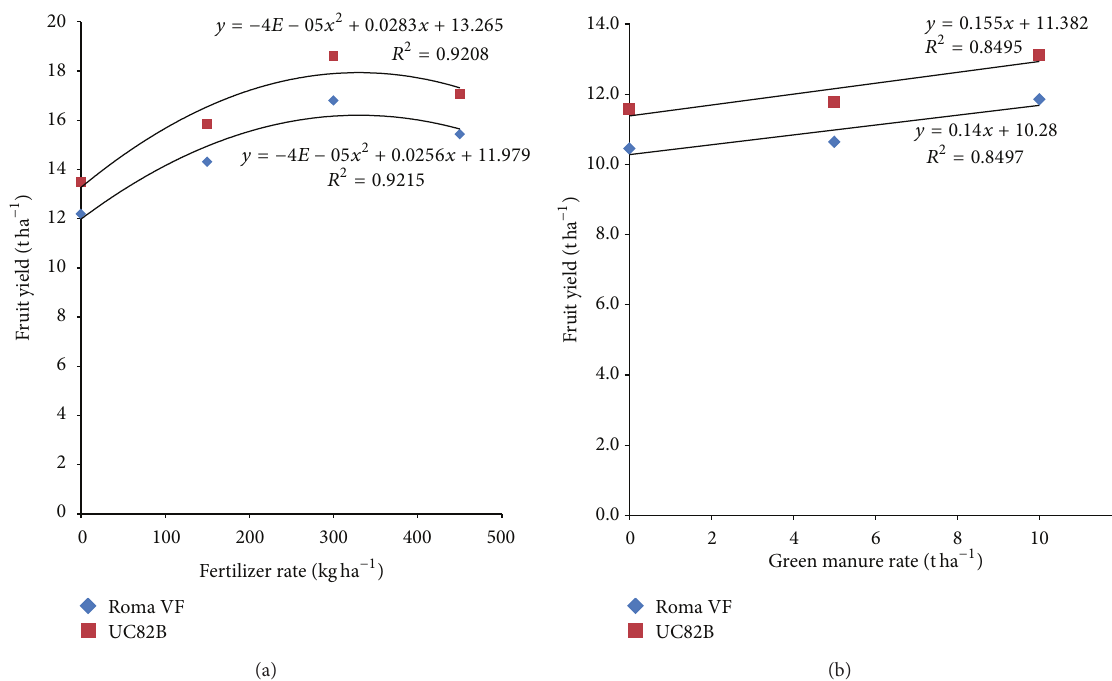
Figure 3: Regression analysis based on mean value of NPK fertilizer rate (a) and green manure rate (b) of two tomato varieties fruit yield tha −1